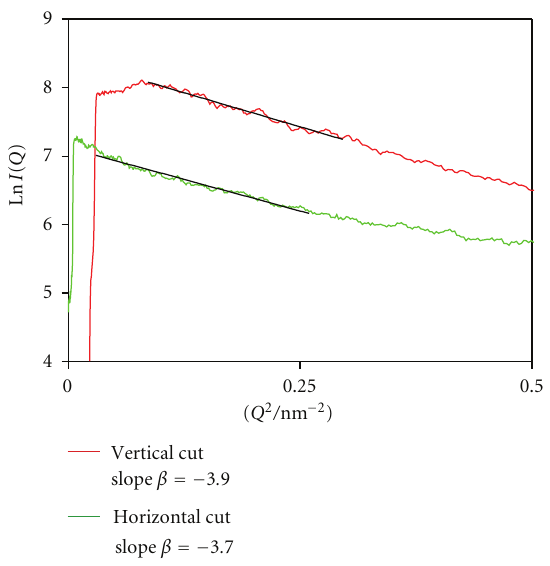
Figure 6: Scattering curves of sample B, extracted from Figure 5(b) as vertical cut at a constant value of the horizontal wave vector (red) and horizontal cut at a constant value of the vertical wave vector (green), shown in the presentation suitable for determination of the average gyration radius. β is the slope of the fitting lines